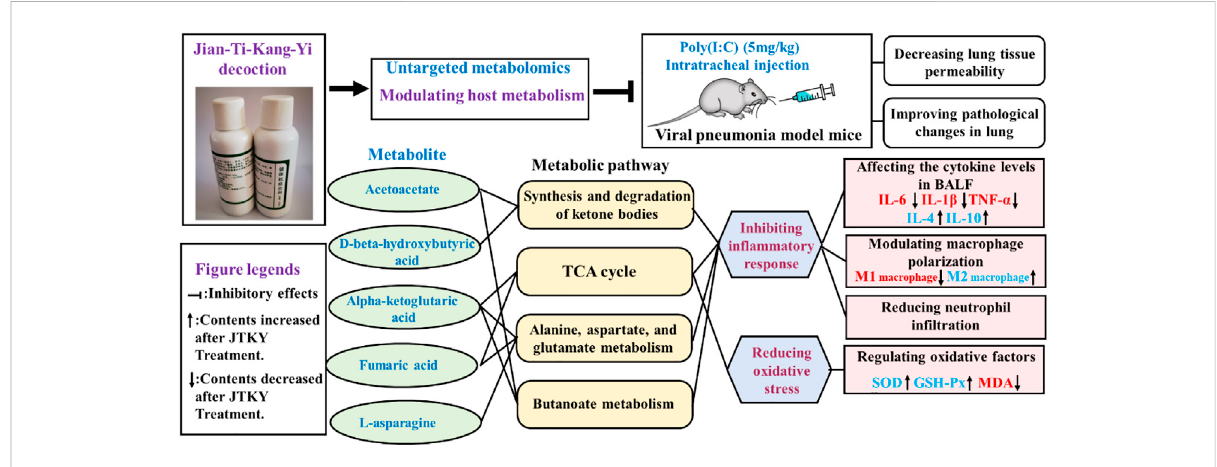
FIGURE 5 Graphical abstract. “ ┤ ” indicated the inhibitory effects. “ ↑ ” indicated the increase of contents after JTKY treatment. “ ↓ ” indicated the decrease of contents after JTKY